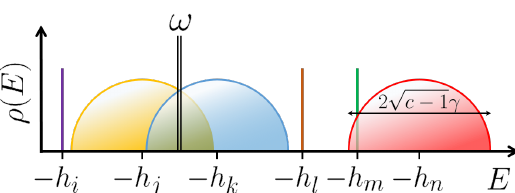
Figure 3: Scheme representing the resonance condition for different layers (labelled i , j , k , l , m , n ) with RRG interactions. The density of states in layers i , l and m corresponds to a delta peak, which is characterized by an absence of RRG interactions ( γ the contrary for layers j , k and n the density of states has a width of 2 γ = γ = γ (cid:54) = 0. Layers j and k correspond to the scenario in which a resonance is formed, j k n their density of states is non-zero for E = ω and consequently it generates a peak in the LDoS around layers j and k . For layers i , l , m and n however we have no overlap between the probing frequency ω and ρ ( E ) , thus there is no resonance in this case. In general, this means that only the RRG interactions corresponding to the scenario of layers j and k form a resonance in the